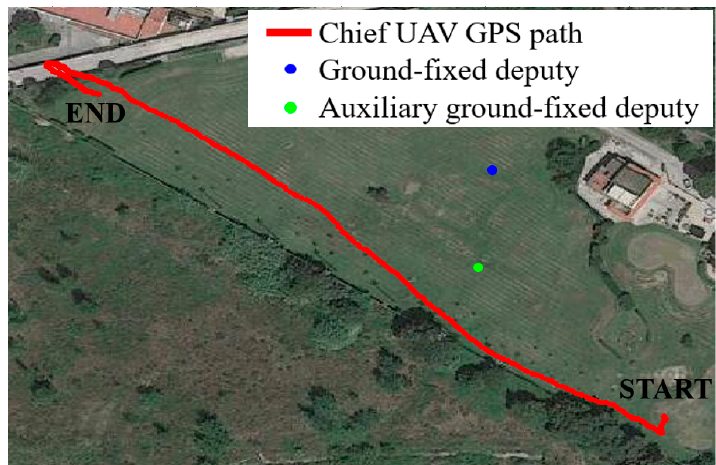
Figure 4. Flight path of the chief (UAV to be calibrated) during the experimental test. The locations of the deputies (ground stations) on the test site are also highlighted.